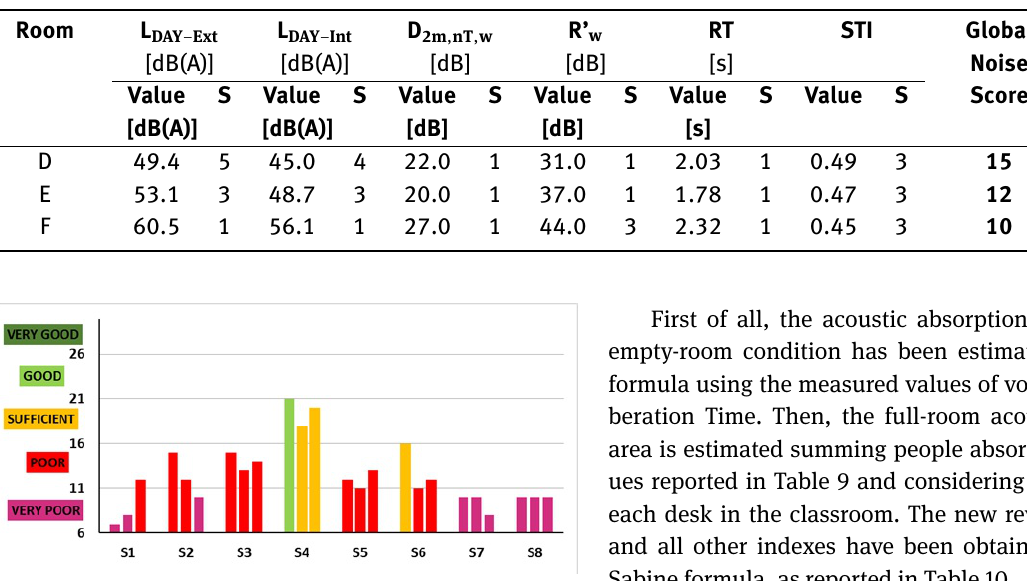
Figure 4: Reverberation time and STI. Table 8: Scores (S) and evaluation for Valdarno schools.